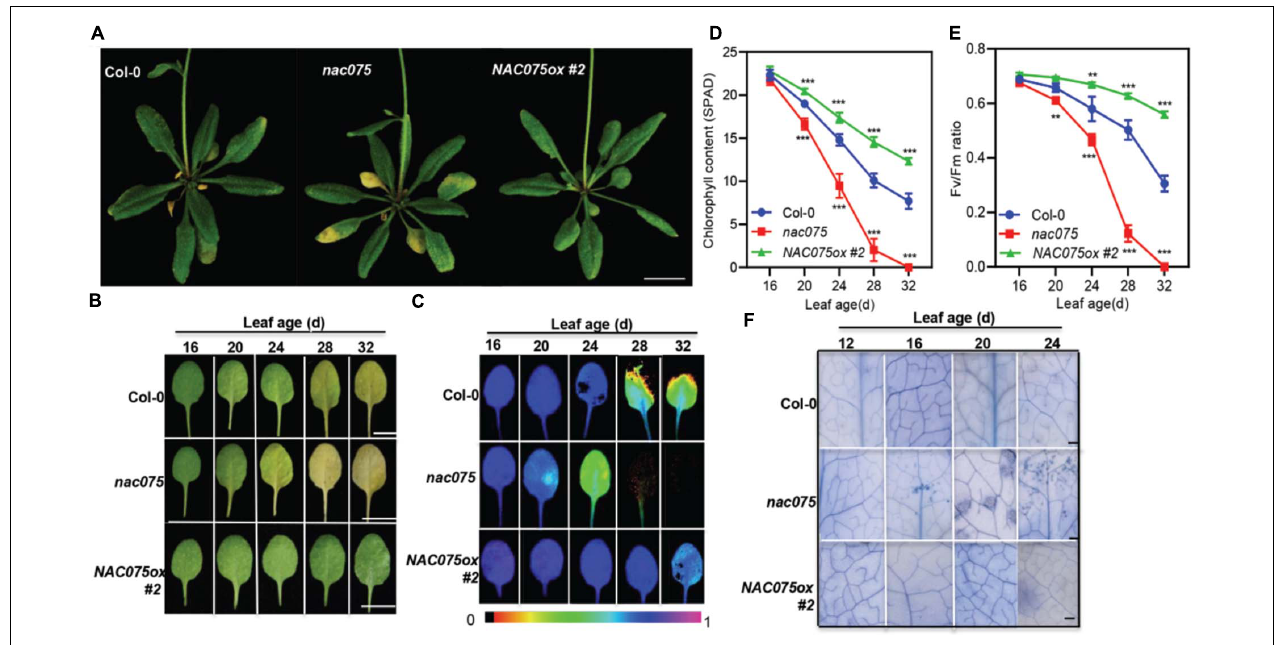
FIGURE 2 | Age-dependent senescence symptoms in the nac075 mutants and NAC075ox plants. (A) The senescence phenotypes of 30-day-old Col-0, nac075 mutants, and NAC075ox plants. Early onset of leaf senescence in nac075 mutant was observed compared with Col-0 plants grown under long-day condition. Scale bar, 1 cm. (B) The age-dependent leaf senescence phenotype of Col-0, nac075 mutants, and NAC075ox plants. Photographs show the third or fourth rosette leaves at the indicated days after emergence (DAE). Scale bar, 1 cm. (C) Analysis of Fv/Fm in Col-0, nac075 mutants, and NAC075ox plants as leaves age. Image generation was performed by IMAGING-PAM. Image processing was performed by Imaging Win software. (D,E) Chlorophyll content (D) and Fv/Fm (E) in Col-0, nac075 mutants and NAC075ox plants as leaves age. Error bars indicate SD ( n = 3). Student’s t test, ∗∗ P < 0.01, ∗∗∗ P < 0.001. (F) Trypan blue staining of leaves at the indicated leaf age. In each plant leaf, dead or dying leaf areas formed blue-colored patches of cells by trypan blue staining. Bar = 500 µ m.